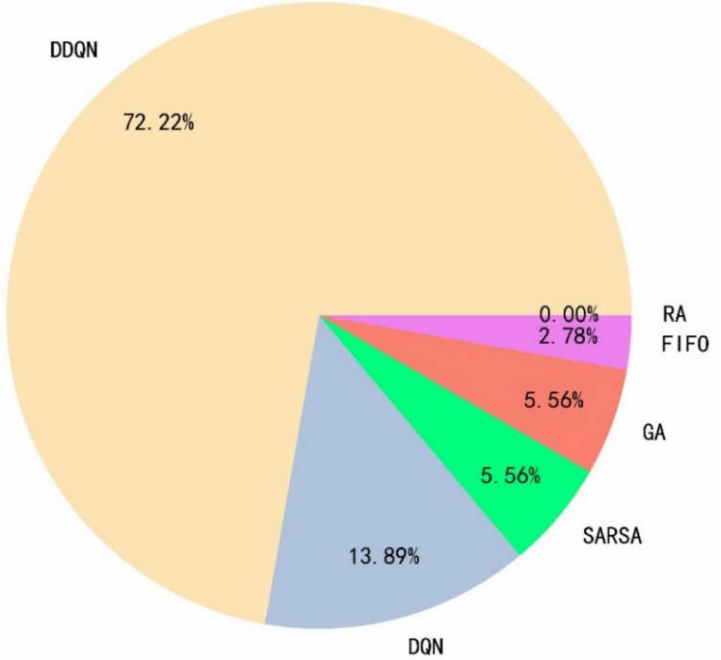
Figure 6. Winning rate of the DDQN and other algorithms, calculated according to Table